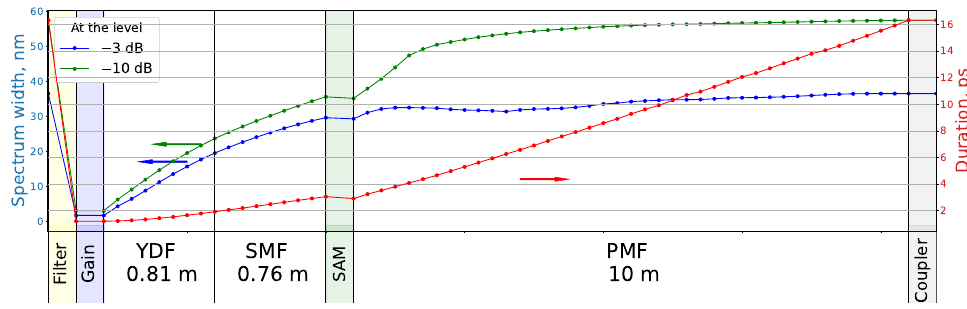
Figure 4. Numerical simulation of the pulse evolution inside the laser